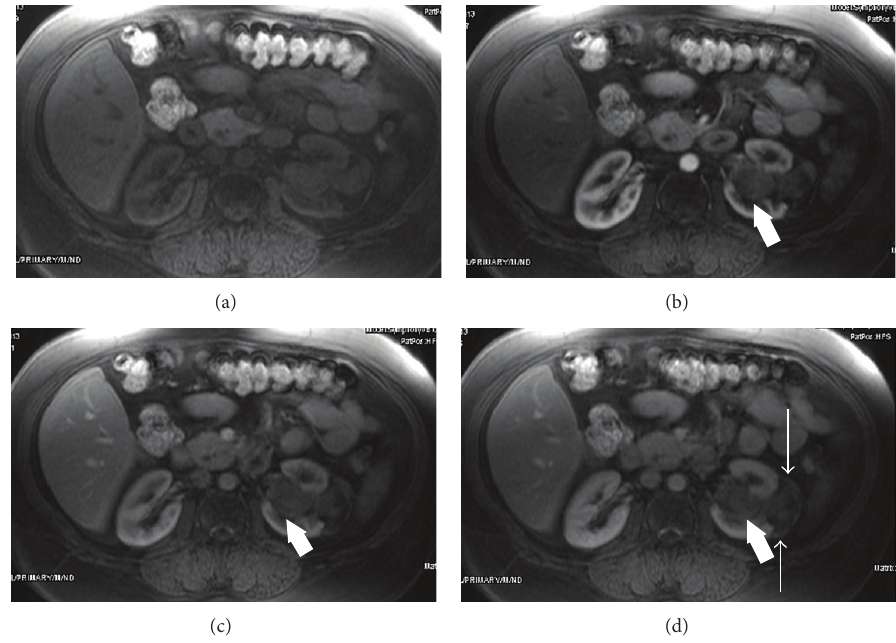
Figure 2: (a–d) Precontrast axial T1W fat-saturated (a), early arterial (b), late arterial (c), and portal venous phase (d) images show slightly increased enhancement in fatty areas of subcapsular portion in portal phase (thin arrow). However, nonadipose component of E-AML is not avidly enhancing in the postcontrast images (thick